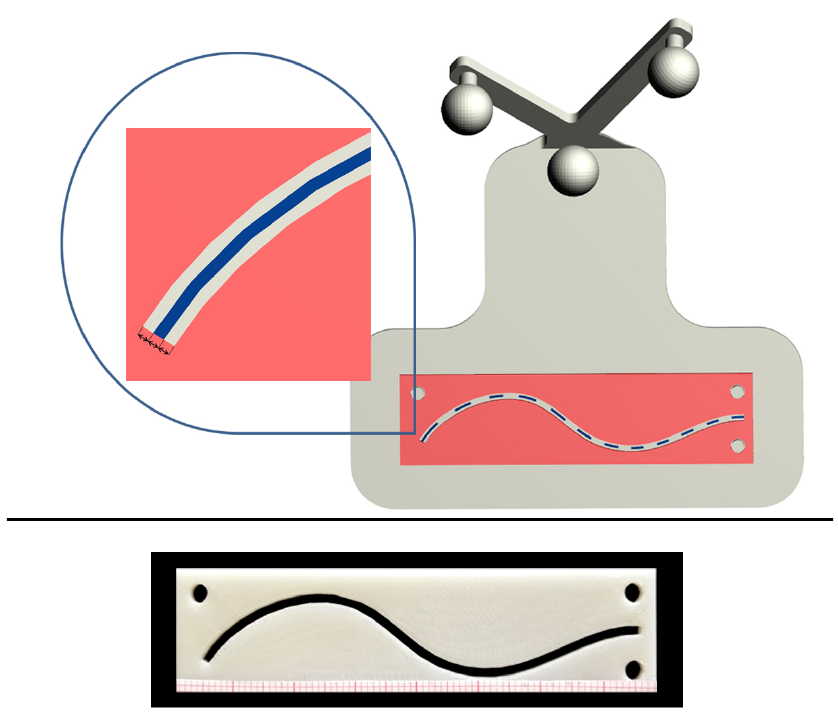
Figure 5. Top: CAD model of the 0.5 mm accuracy level template designed for T1, with a zoomed detail of the inspection window (1.5 mm in width). Bottom: 3D printed template with stripes of graph paper to estimate the cumulative length of the traced trajectory within the inspection